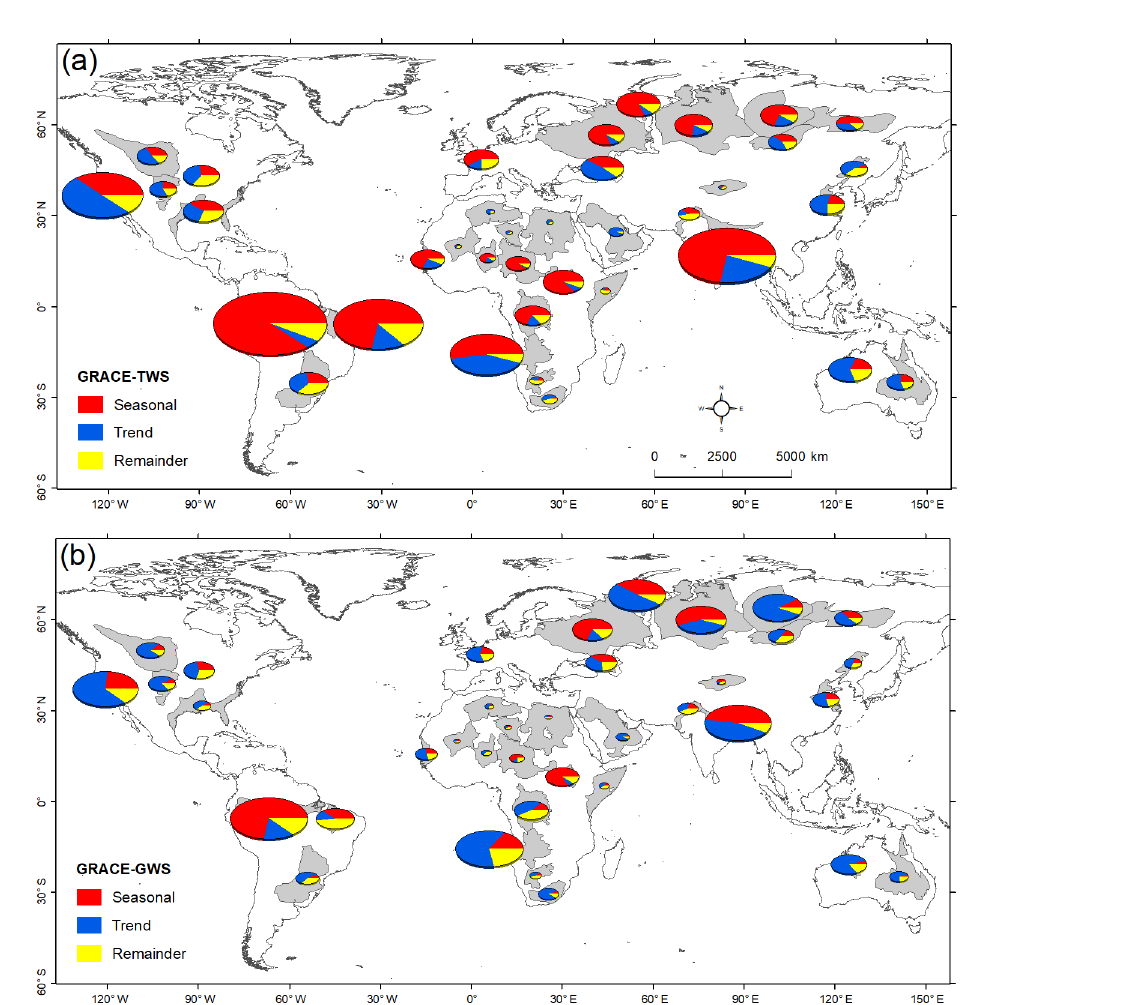
Figure 3. Seasonal trend decomposition of (a) GRACE (cid:49) TWS and (b) GRACE (cid:49) GWS time series data (2002 to 2016) for the world’s 37 large aquifer systems using the STL decomposition method; seasonal, trend, and remainder or irregular components of time series data are decomposed and plotted as pie charts that are scaled by the variance of the time series in each aquifer system.